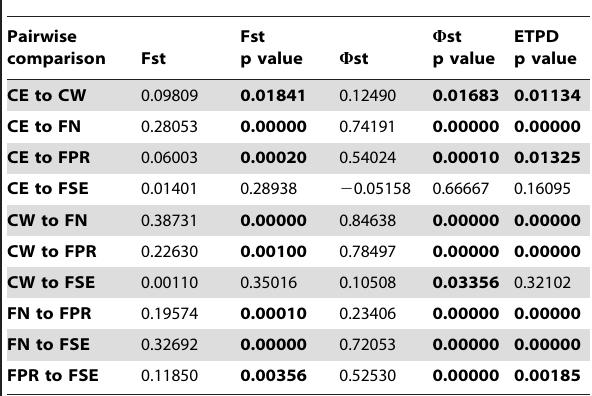
Table 1. Pairwise fixation index results. Table 2. Isolation by distance (IBD) and isolation by environmental distance (IBED)